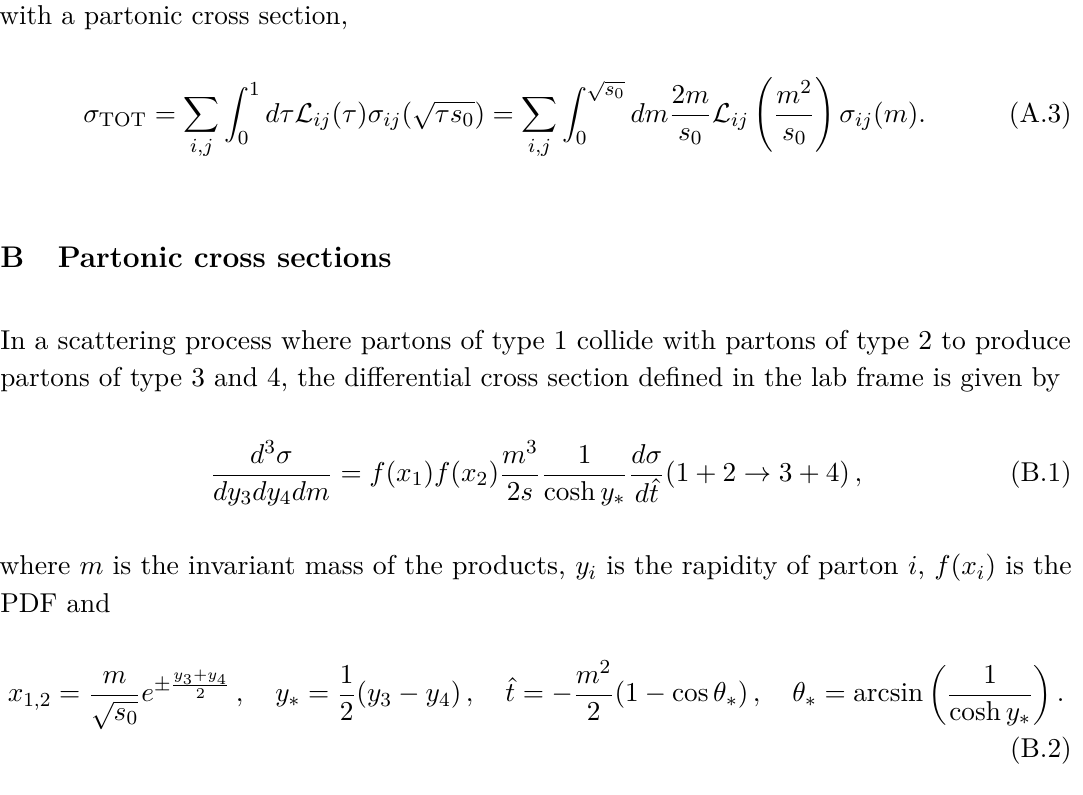
Figure 19 . Parton luminosities, for ¯ b